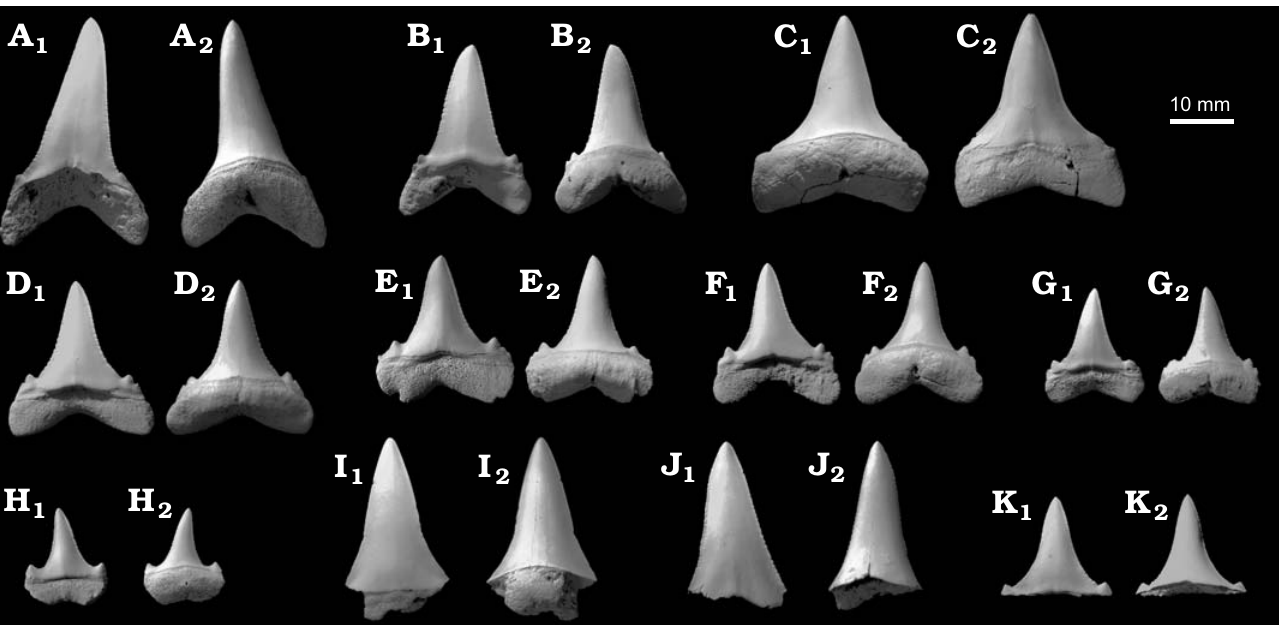
Fig. 11. Lower jaw teeth of the mackerel shark Carcharomodus escheri (Agassiz, 1843), MNU 071-20, from Groß Pampau, the middle–late Miocene. A . Lower left anterior tooth. B . Lower left intermediate tooth. C – H . Lower lateral teeth. Labial (A lower lateral tooth. J , K . Incompletely mineralized lower replacement